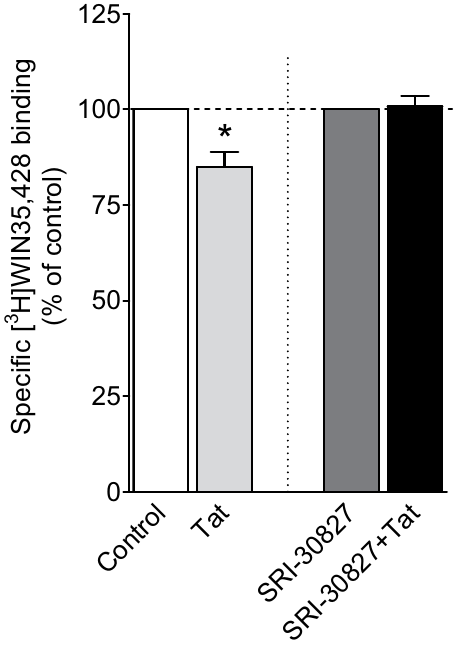
Figure 4. Effect of SRI-30827 (50 nM) on Tat-induced inhibition of [ 3 H]WIN35.428 binding in WT hDAT. CHO cells transfected with WT hDAT were incubated with [ 3 H]WIN 35,428 (final concentration, 5 nM) with or without recombinant Tat 1–86 (rTat 1–86 ) (40 nM, final concentration) on ice for 2 h. Nonspecific uptake was determined in the presence of 30 µ M final concentration of cocaine. Data for rTat 1–86 and SRI-30827 + rTat 1–86 are expressed as the percentage of their respective controls in the absence of rTat 1–86 (15675 ± 2982 DPM) and SRI-30827 (14041 ± 3212 DPM) n = 5. * p < 0.05 compared with control